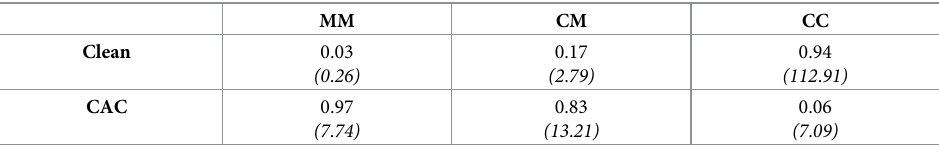
Table 4. Summary—performances ‘per corner ‘and ‘per patient’. Recall